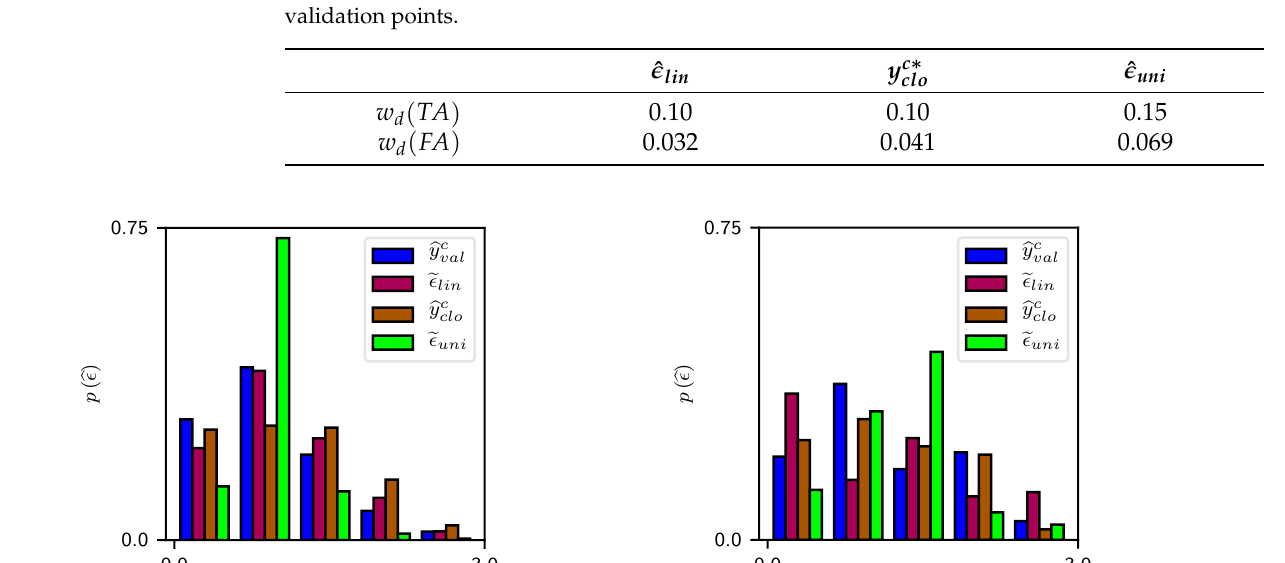
( b ) HRR max = 115MW, t HRR = 1121s, t pre = 202s, N tu = 52 and FA and the closest data point HRR max = 94MW, t HRR = 1031s, t pre = 201s, N tu = 71. of the batch design and the closest data point y c ∗ val clo